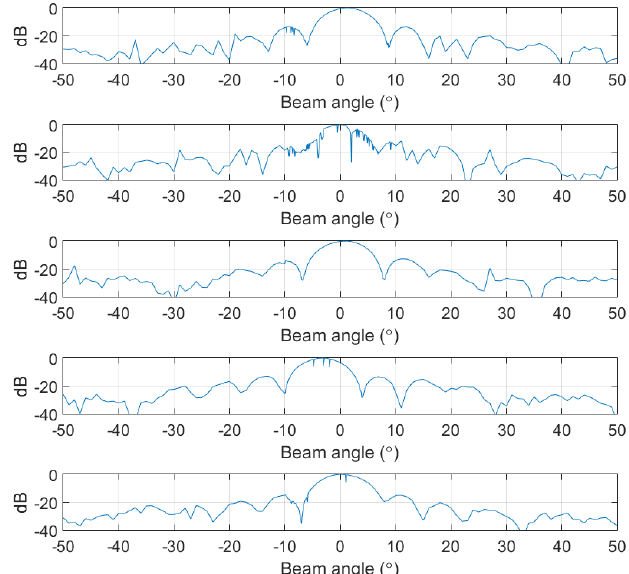
Figure 10. Examples of subarray beam patterns obtained from near-field measurements: ( a ) ex 1; ( b ) ex 2; ( c ) ex 3; ( d ) ex 4; ( e ) ex 5.